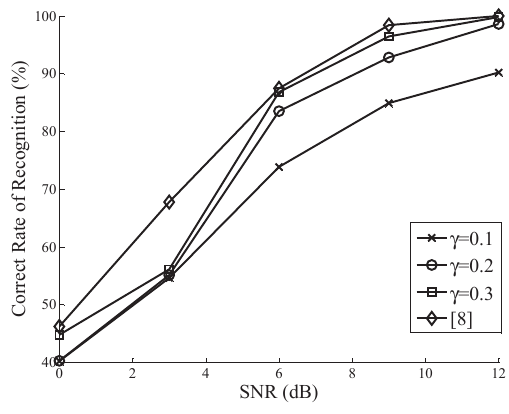
Figure 2. Performance versus SNR for Ω 2